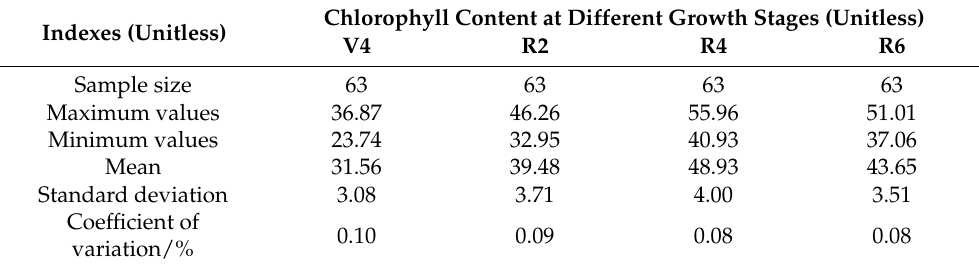
Table 1. Statistics of chlorophyll content data at different growth stages of